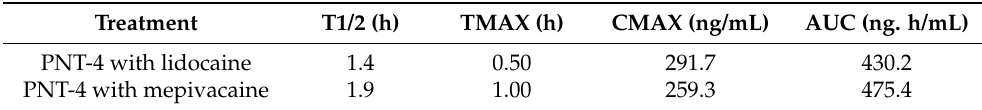
Figure 4. Pharmacokinetics curves of lidocaine and mepivacaine in rat plasma from PNT-4. PNT-4 gels were injected intradermally into rats. After a quick release of anesthetic in the plasma in the first hour, a rapid decrease of the plasma concentrations of both anesthetics was observed for 6 h. Lidocaine appeared in the plasma first and reached a higher maximum concentration compared to mepivacaine, while the mepivacaine plasma concentration was sustained for a longer duration compared to lidocaine. However, no statistical differences were observed between formulations at any timepoint. Three repeated measurements ( n = 3) were carried out for each condition. Results are expressed as means ± SD. Table 3. Pharmacokinetic parameters for lidocaine and mepivacaine after intradermal injection of PNT-4 with lidocaine and mepivacaine in rats.